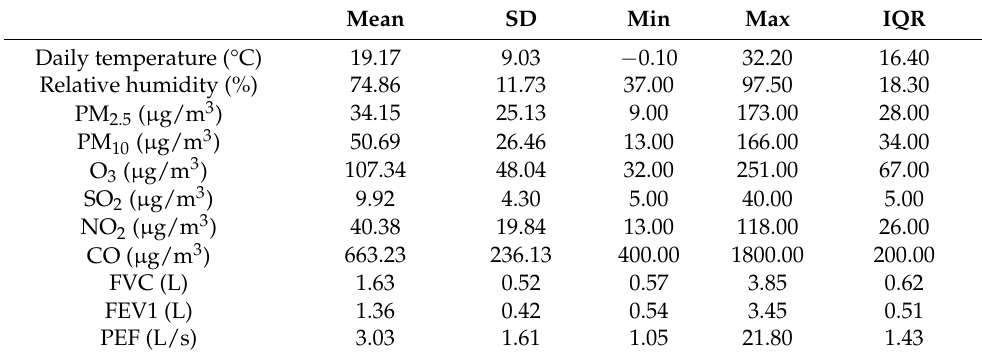
Table 2. Description of basic meteorological pollutants and lung function